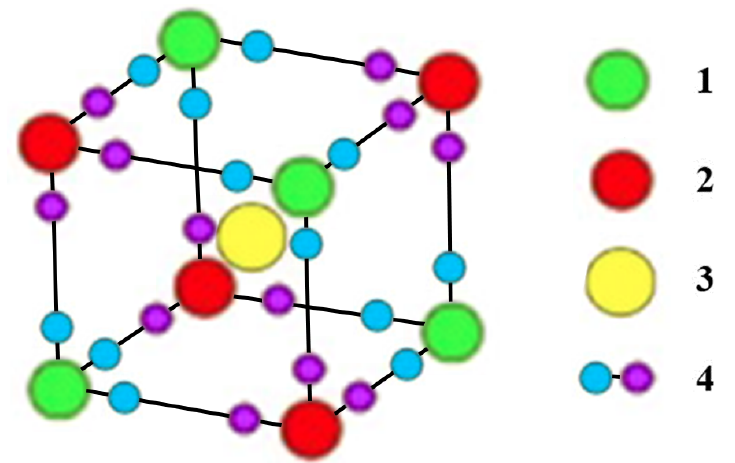
Figure 3. A crystal structure model of mixed ferrocyanides. 1—Me (II); 2 is Fe (II); 3 is Me (I); 4 is